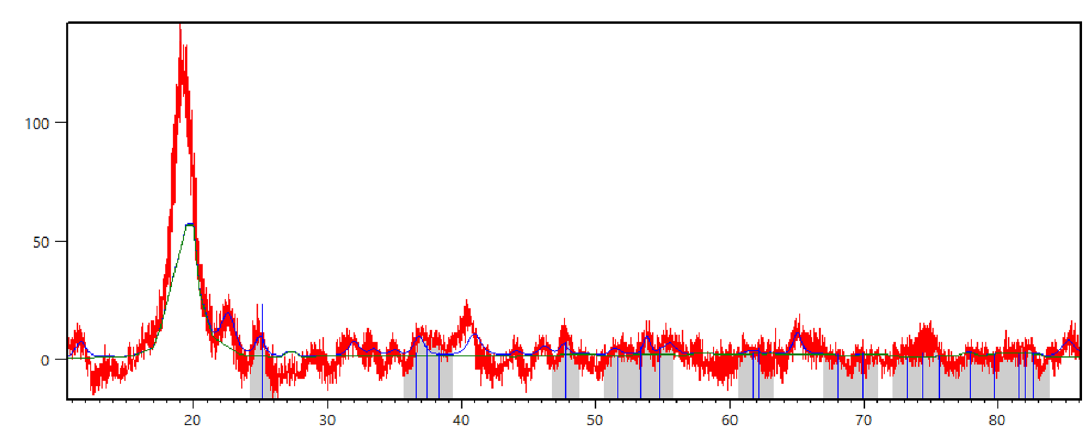
Figure 5. The XRD pattern of the synthesized nanocomposite TiO 2 @PVA with red line pattern and blue peaks for anatase TiO